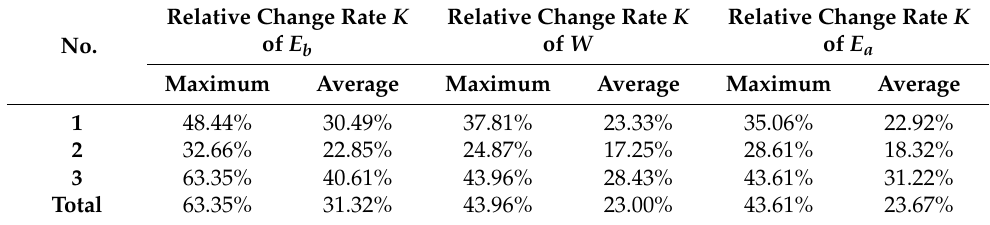
Table 11. Sensitivity analysis of indices for optimization of